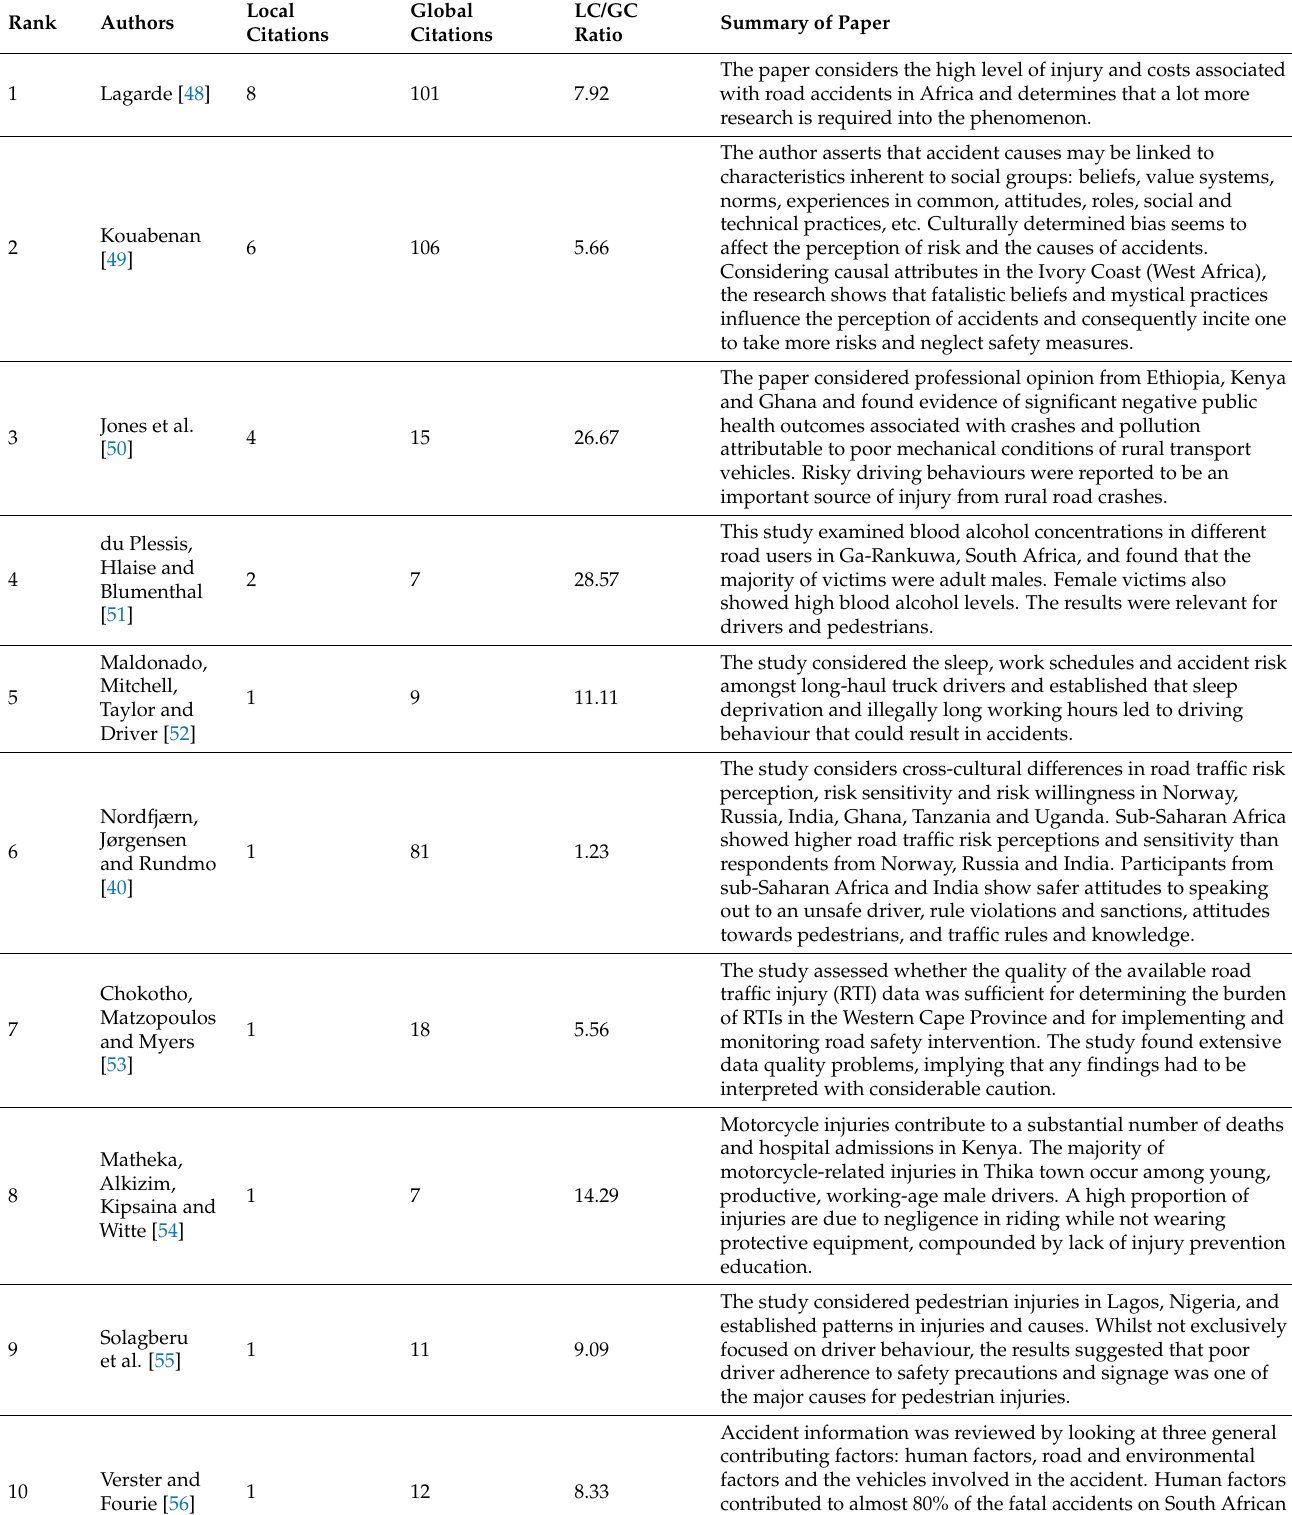
Table 6. Top 10 cited